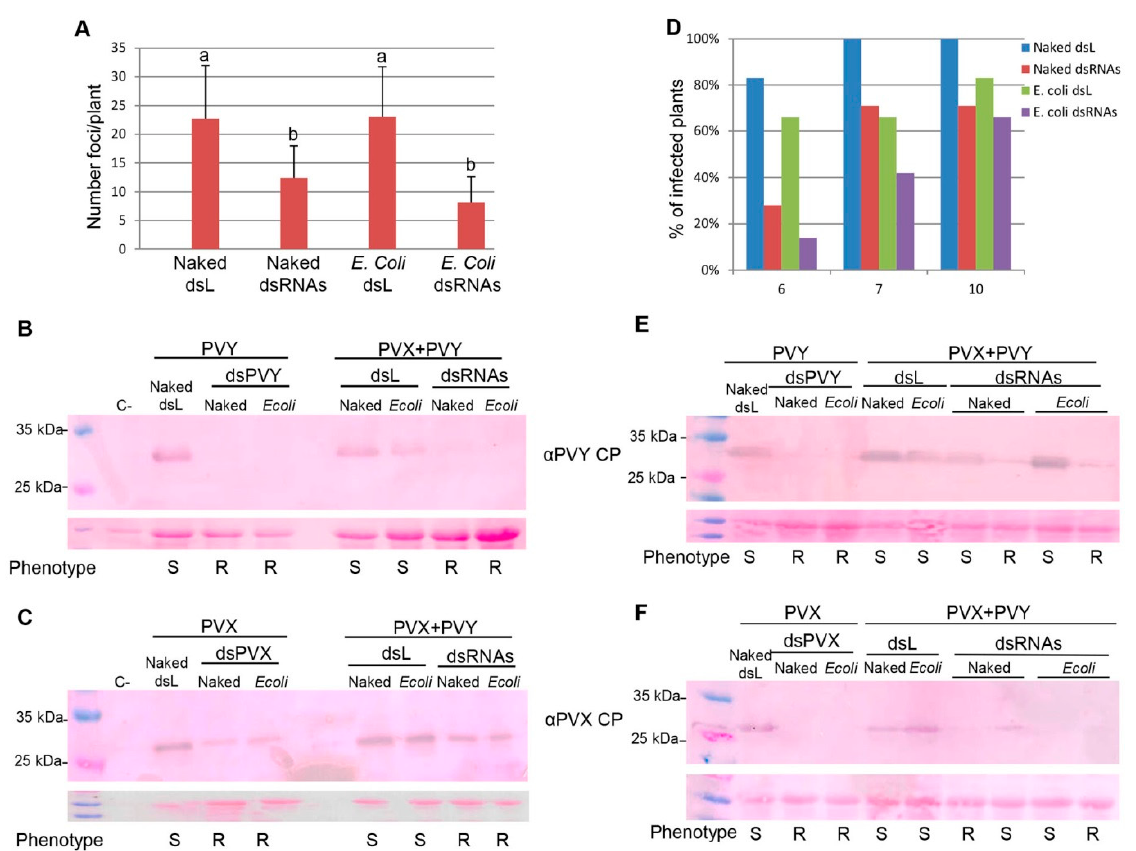
Figure 5. Bacterially produced dsRNA delays dual infection by PVY and PVX-GFP . N. benthamiana plants were inoculated with PVX-GFP plus PVY combined with E. coli -encapsulated dsPVX and dsPVY ( E. coli dsRNAs), PVX-GFP plus PVY combined with naked dsPVX and dsPVY (naked dsRNAs), PVX-GFP plus PVY combined with E. coli -encapsulated dsL, and PVX-GFP plus PVY combined with naked dsL. For controls, plants were singly infected with PVX-GFP or PVY together with the corresponding dsRNA targeting the homologous virus. ( A ) Mean numbers ± standard deviations of PVX-GFP foci on doubly inoculated leaves of plants with the different treatments at 4 days post-inoculation (dpi). Different letters indicate significant differences determined by employing Scheffé’s multiple range test ( p < 0.05). Western blot analysis of plant extracts derived from inoculated leaves at 4 dpi, using antibodies against PVY CP ( B ) and PVX CP ( C ). Plants susceptible (S) or resistant (R) to virus infection at 6 dpi are indicated. Lane C corresponds to the extract from a non-infected plant. ( D ) The percentage of inoculated plants showing systemic symptoms was monitored at different dpi. Western blot analysis of plant extracts derived from upper leaves of plants susceptible (S) or resistant (R) at 7 dpi, using antibodies against PVY CP ( E ) and PVX CP ( F ). The lower panel shows the Ponceau S-stained membrane after blotting, as a control of loading.